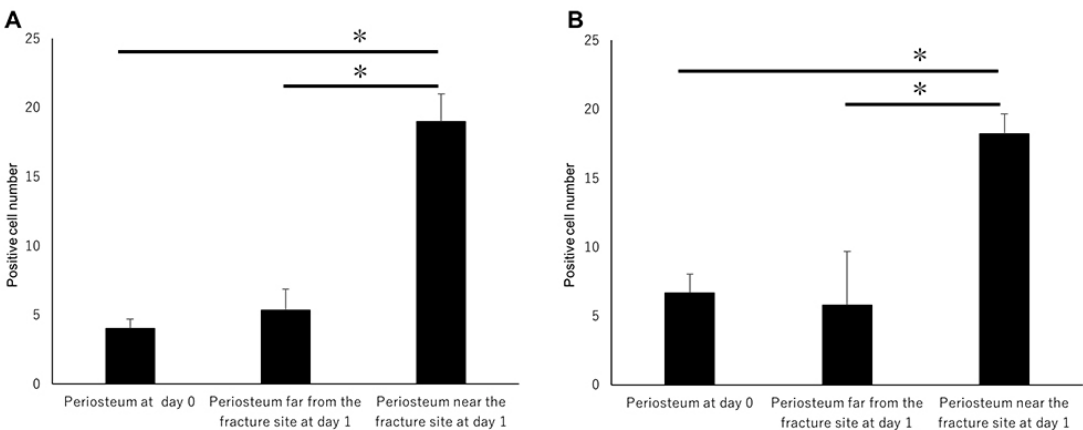
Figure 5. The positive cell number count on day 1. ( A ) Shh-positive and ( B ) Gli1-positive cell numbers in the periosteum near the fracture site were remarkably higher than those far from the fracture site. (A) Shh-positive and (B) Gli1-positive cell numbers in the periosteum near the fracture site at day 1 were higher than those at day 0. Data represent the mean ± SE ( n = 3 / group). Asterisks indicate the statistical significance of the differences (* p < 0.01, Tukey’s test).